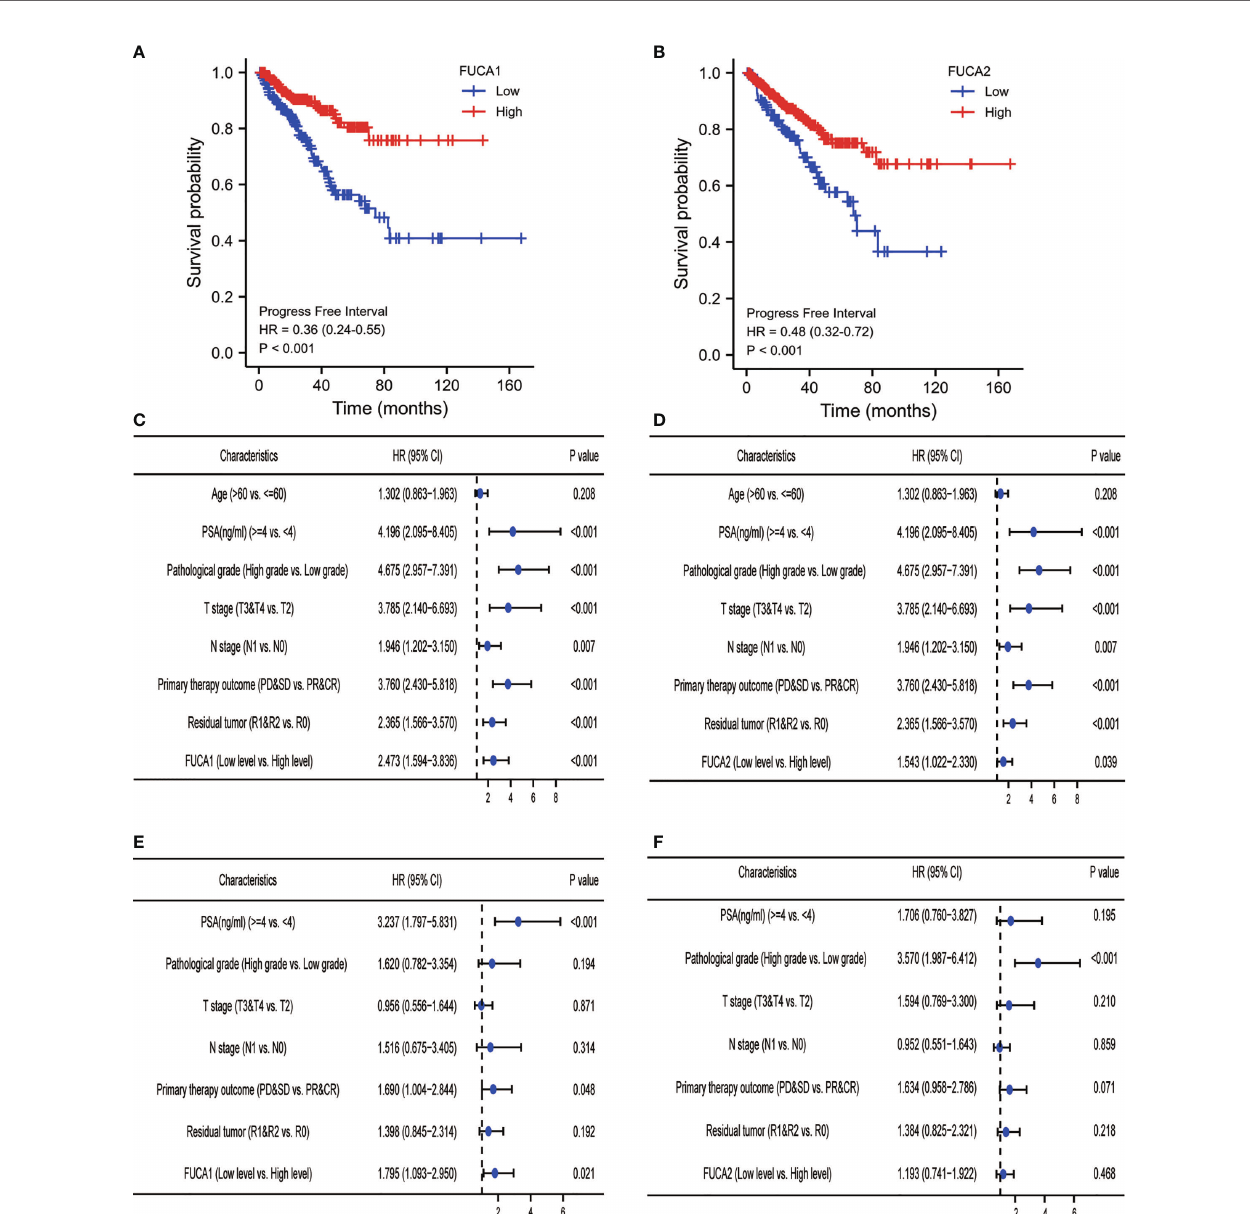
FIGURE 5 | Survival analysis of PCa patients with different FUCA1 / FUCA2 expression based on TCGA databases. The Kaplan – Meier curve analysis based on FUCA1 (A) and FUCA2 (B) expression effect for PFI. Univariate Cox regression analysis of FUCA1 (C) and FUCA2 (D) expression effect for PFI. Multivariate Cox regression analysis of FUCA1 (E) and FUCA2 (F) expression effect for PFI. PCa, prostate cancer; TCGA, The Cancer Genome Atlas; PFI, progress-free